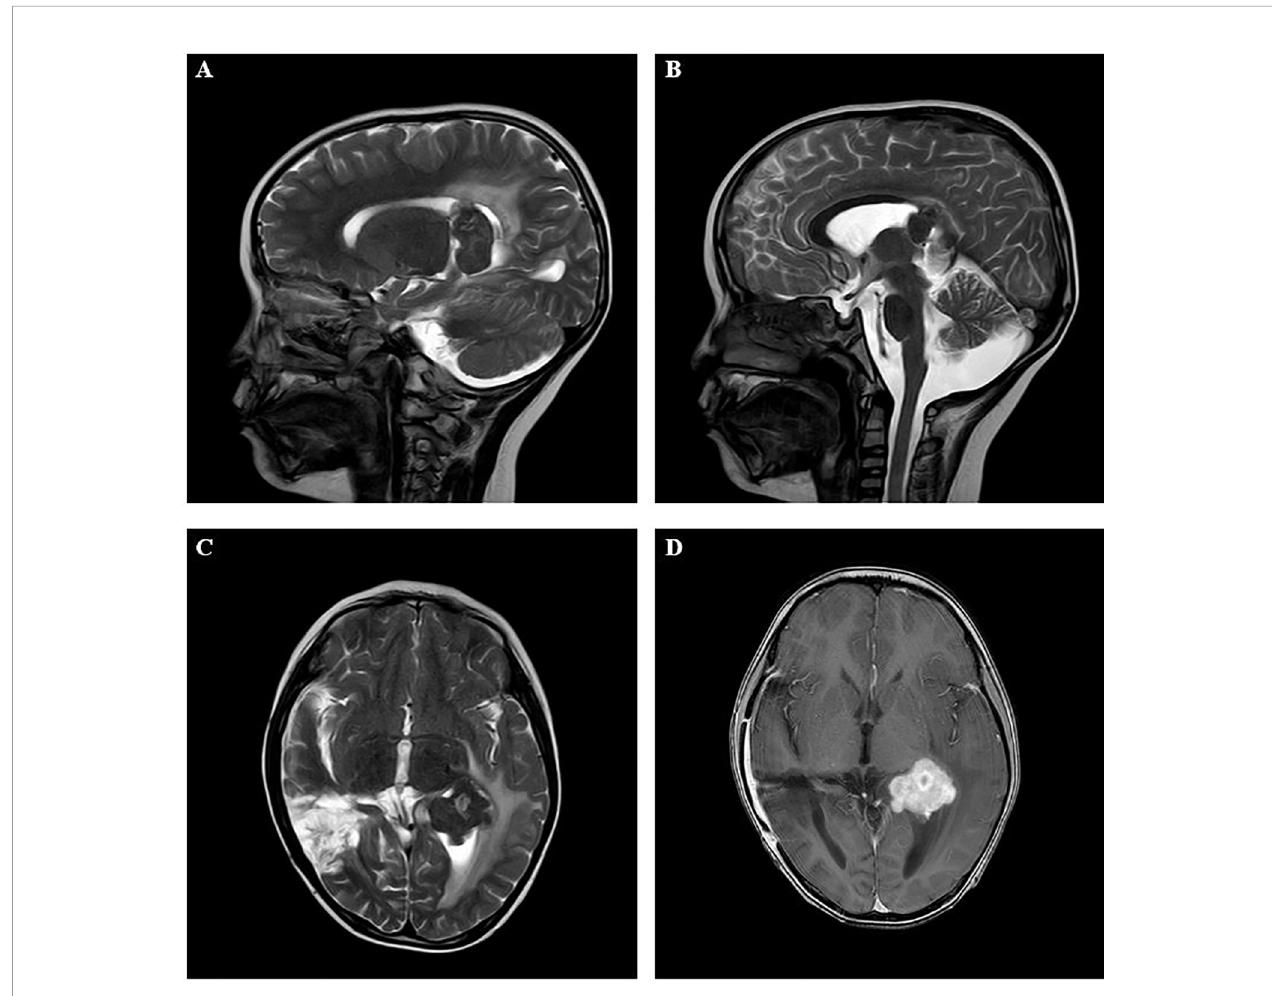
FIGURE 1 | Imaging results in the intracranial lesion tissue. The results of MRI showed the lateral ventricle expansion, with abnormal signal mass shadow (size about 3.3×3.1×3.5cm) in the lateral ventricle. ( A , B : sagittal position; C , D : horizontal position). MRI, Magnetic resonance